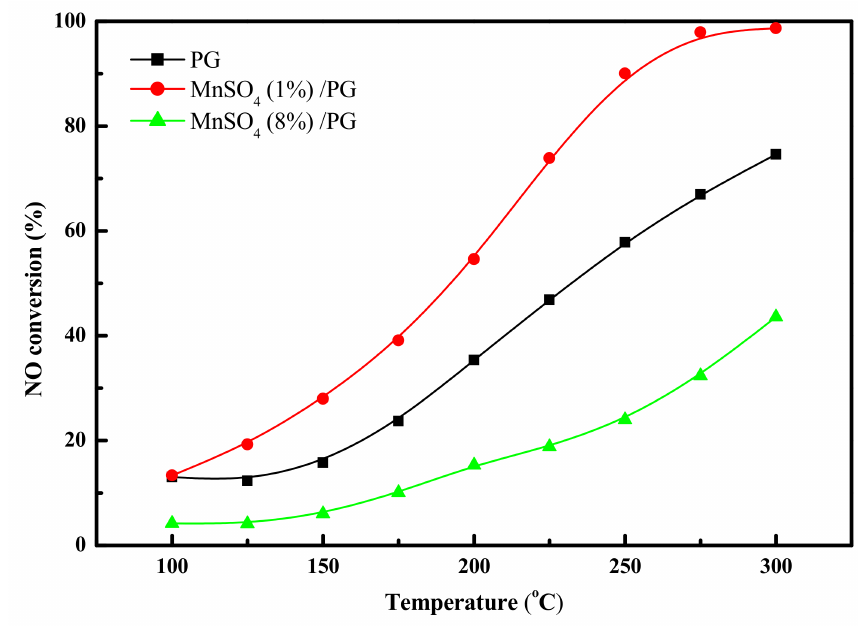
Figure 8. Activity of different PG catalysts. Reaction conditions: [NH 3 ] = [NO] = 600 ppm, [O 2 ] = 3 vol%, Ar balance, GHSV = 7000 h − 1 , total flow rate = 350 mL min − 1